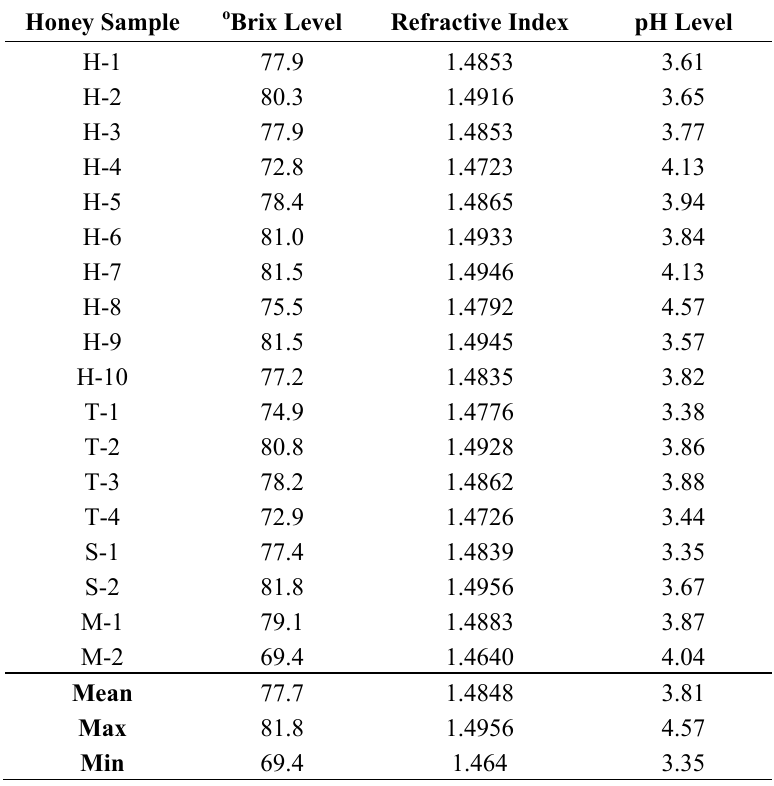
Table 5. Brix, Refractive Index and pH